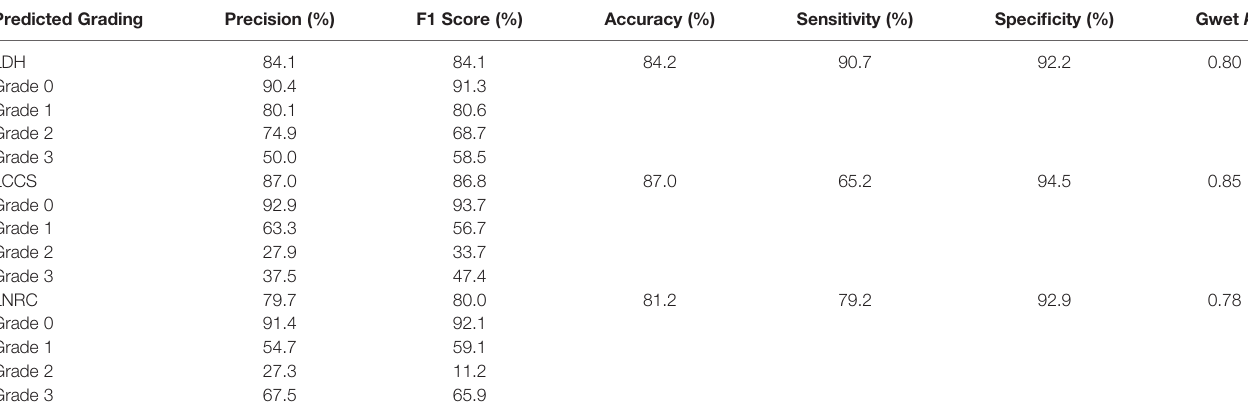
TABLE 3 | The accuracy performance of the multi-task classi fi cation model on the internal test dataset. Predicted Grading